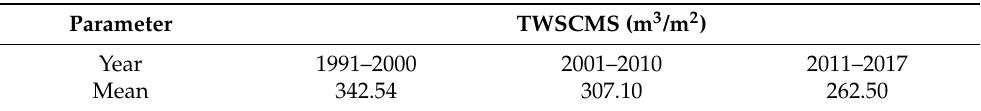
Table 8. Comparison of different categories of mosques based on year built, showing the mean and median values of total water consumption